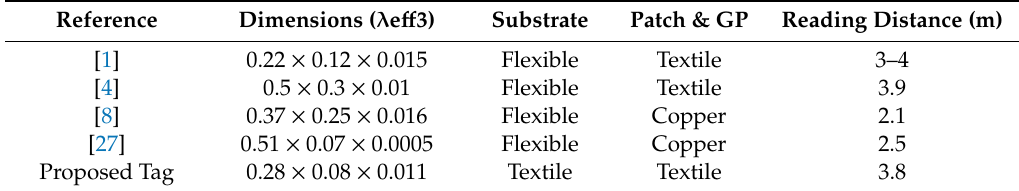
Table 2. Comparison of various body centric antenna properties.